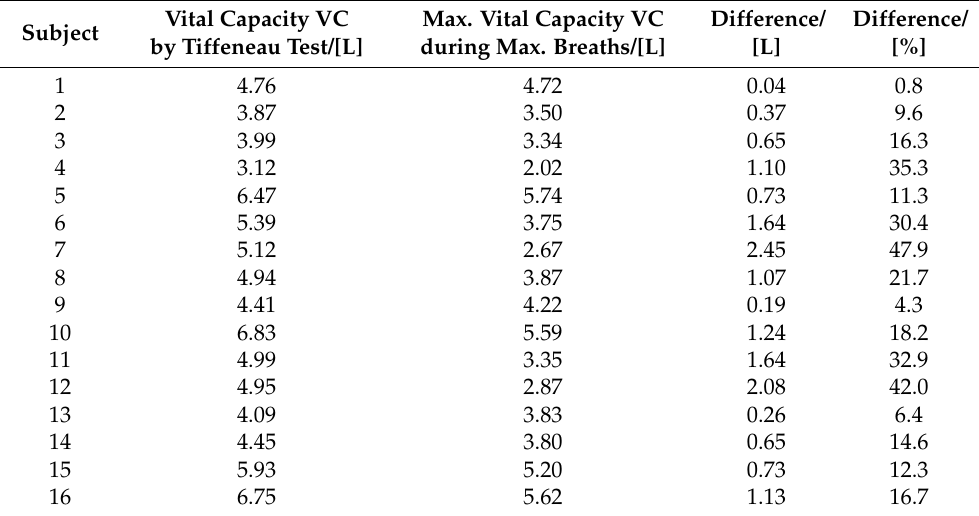
Table 3. Vital capacities obtained by the Tiffeneau Test compared to the maximal vital capacities obtained during maximal